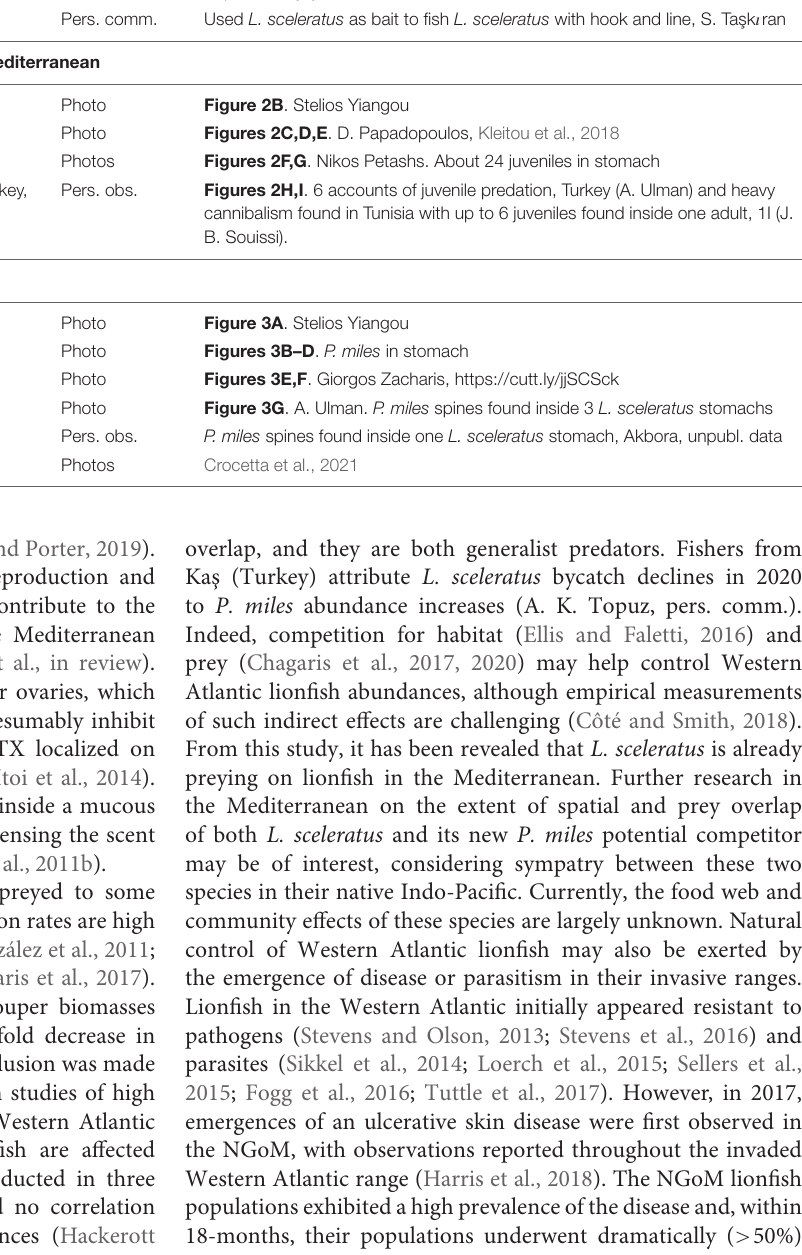
Photo Figure 2B . Stelios Yiangou